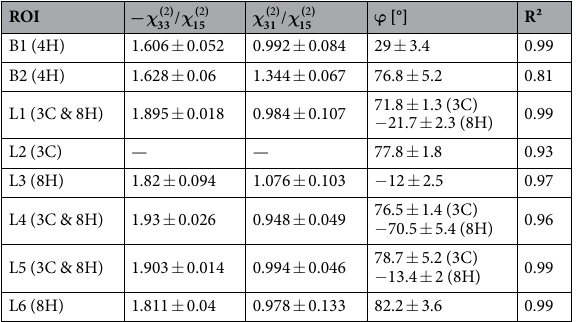
Table 1. Parameters retrieved by the fitting of the experimental data with either Eqs 1, 2 or a linear combination of the two. The behavior of each ROI is indicated (4H, 3C, 8H or a combination of 3C and 8H) as resulted from the fitting with the theoretical